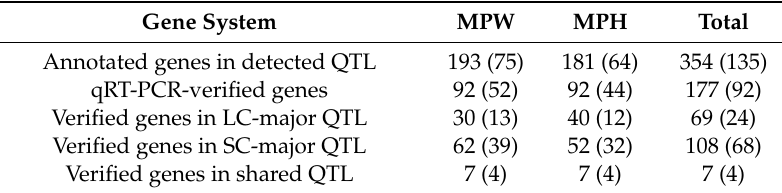
Table 7. The annotated and verified gene systems that confer drought tolerance in the CCSP. Gene System